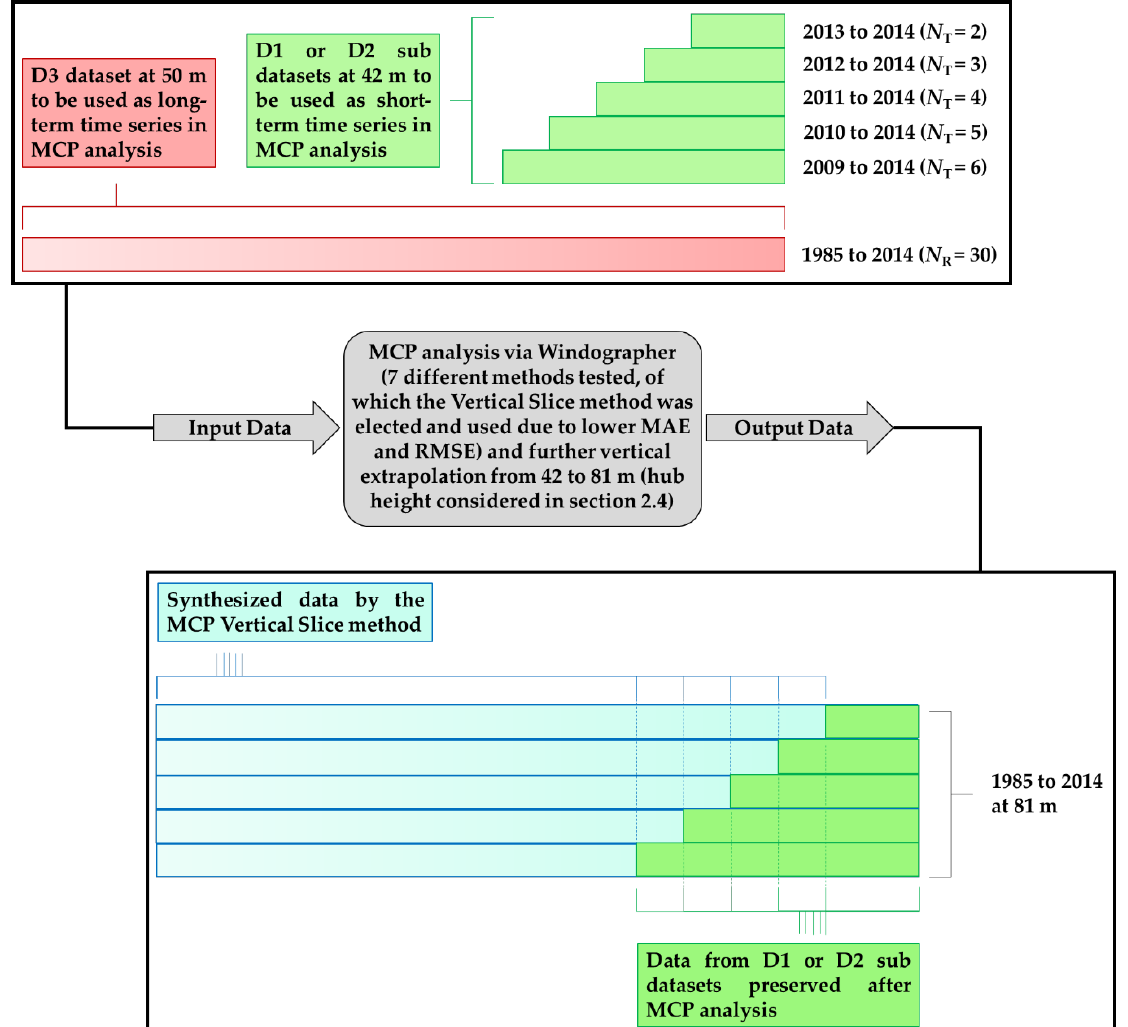
Figure 2. Measure-correlate-predict (MCP) analysis with the Vertical Slice method — elected due to lower mean absolute error (MAE) and root mean squared error (RMSE) and further vertical extrapolation of data.